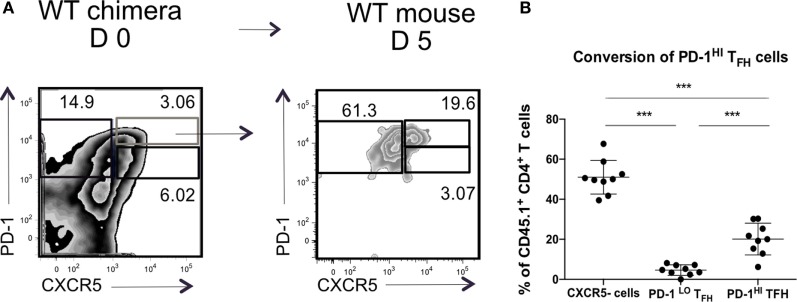
PD-1hi T follicular helper cells (Tfh) are restricted in their ability to convert to PD-1lo Tfh. Chimeric mice were generated and treated as described in Figure 4. (A) Flow cytometry plots of T follicular helper cells (Tfh) populations isolated from WT chimera on day 0 (left) or day 5 post transfer (right). Transferred PD-1hi Tfh population is showed in blue. (B) Summary of the phenotype acquired by PD-1hi Tfh at day 5 post transfer. Data pooled from two independent experiments with four and five animals per group, each dot represents one mouse. Statistical significance was determined by one-way ANOVA with post-ANOVA Tukey’s test for multiple comparisons.